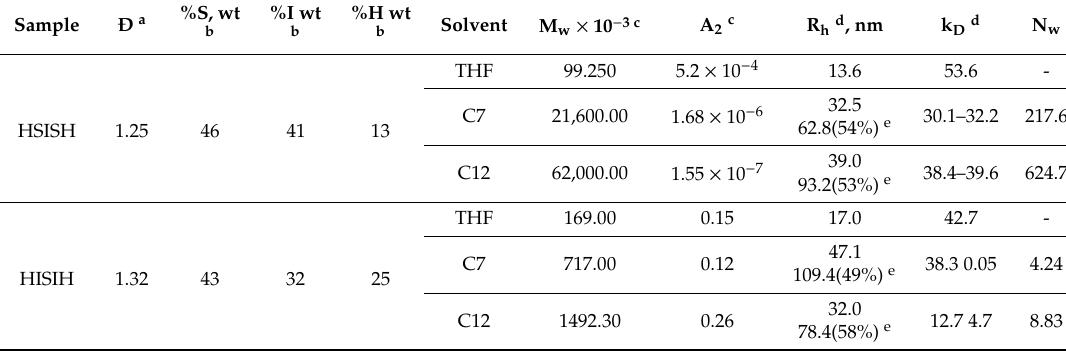
Table 6. Molecular characteristics of the HSISH and HISIH pentablock terpolymers and their micellar characteristics in n-heptane and